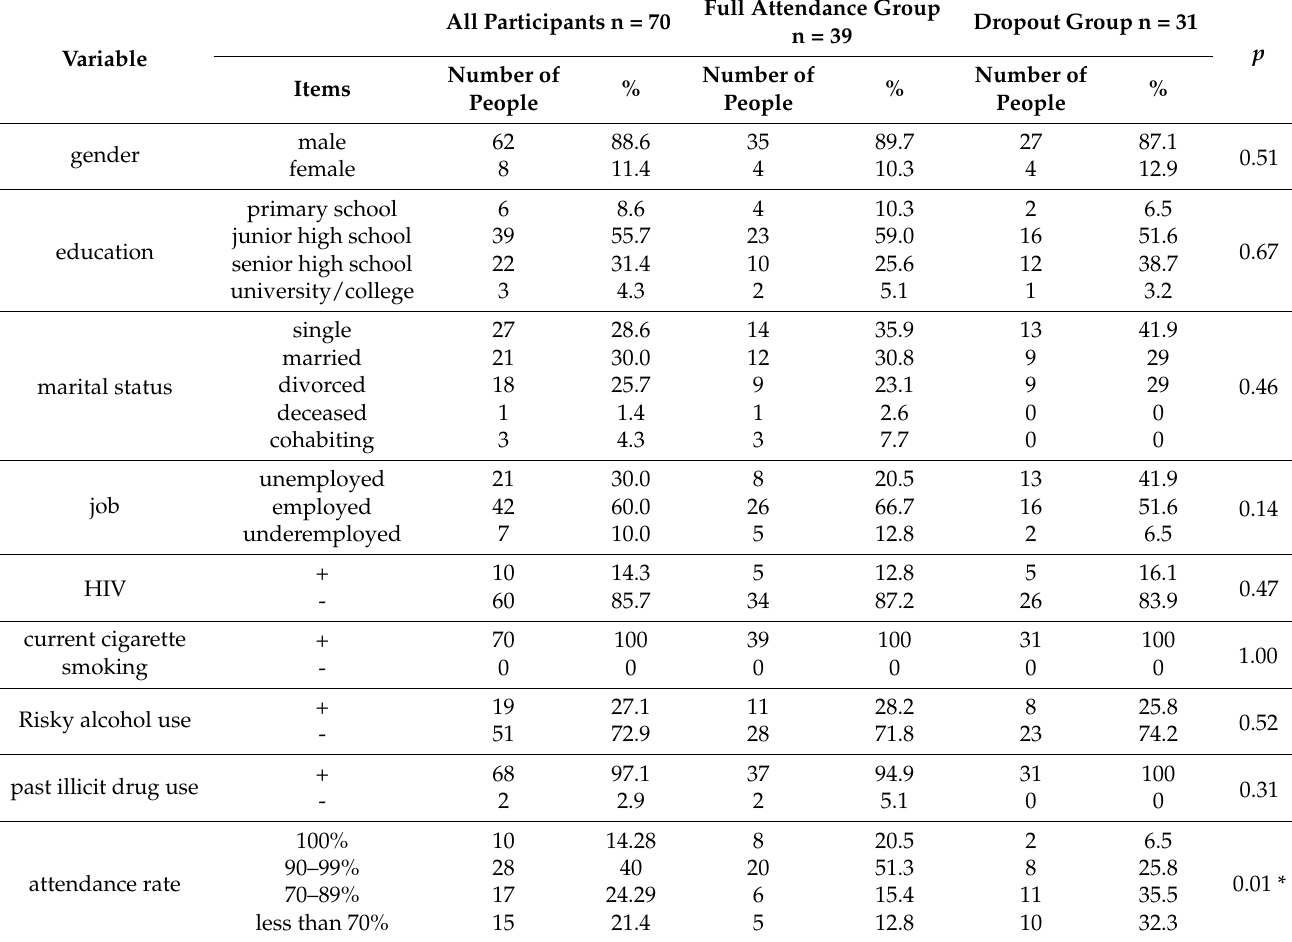
Table 1. Descriptive characteristics of all participants, full attendance group, and dropout